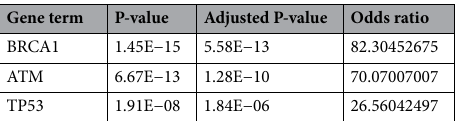
Table 1. The p-value of genes computed from the fisher’s exact test.